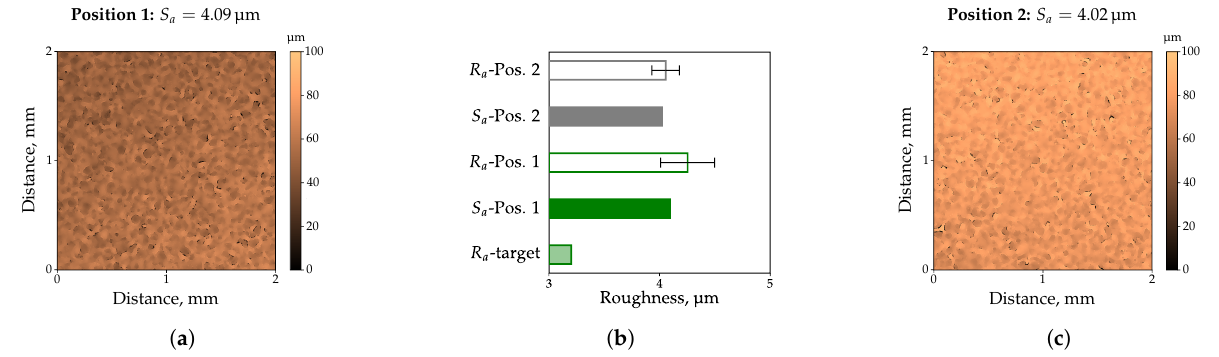
Figure 3. Reproducibility of surface S a and line roughness R a based on insert with the highest target line roughness of 3.2 µ m. Topographies of Position 1 ( a ) and Position 2 ( c ) are similar. The determined roughness values are equal but are approx. 30% higher compared to the target line roughness value of the insert ( b ).